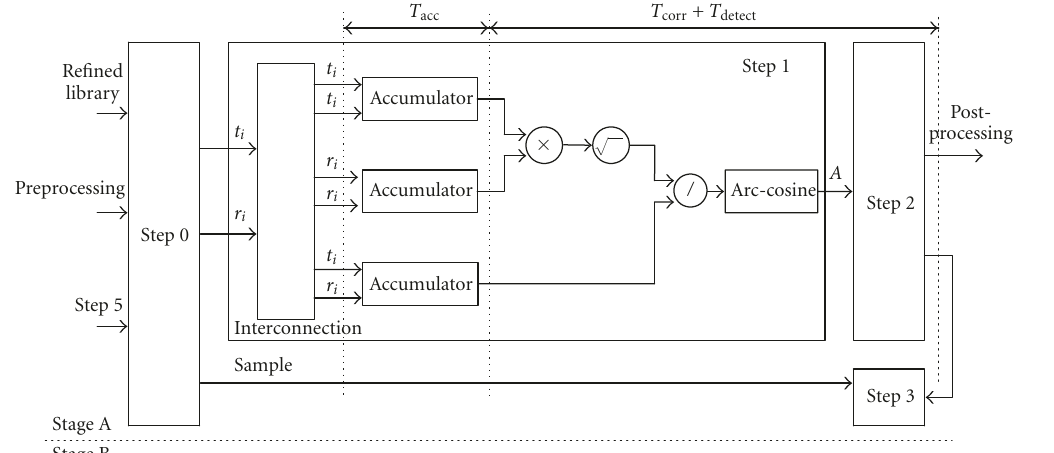
Figure 9: Illustration of pixel-based execution pipeline structure in Stage A where three accumulators are